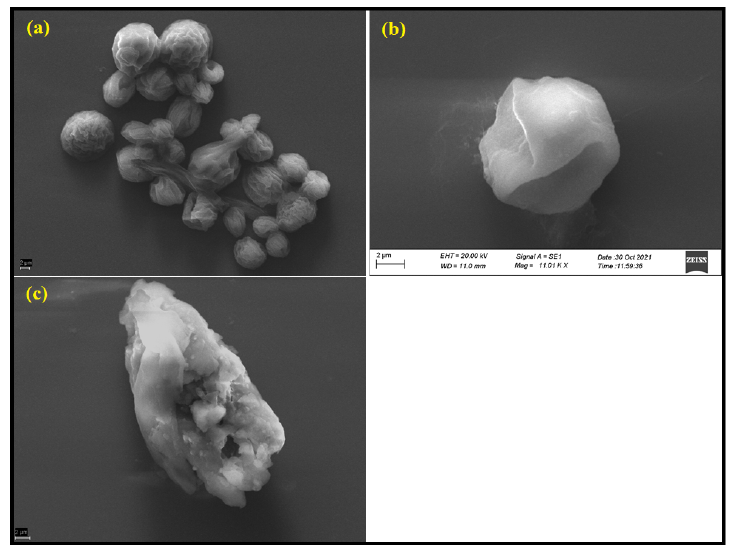
Figure 7. Scanning electron microscopy images of sporangiospores: ( a ) control, ( b ) treated with PEI-f-AgNP-1, and ( c ) treated with PEI-f-AgNP-2 for 24 h. Further, the EDS analysis of PEI-f-Ag-NP 1 and 2 treated sporangiospores was used to assess the presence of elemental silver distribution in the sporangiospores. In PEI-f-AgNP- 1- and water-treated sporangiospores, no elemental silver was detected, as shown in Figure 8a,b. In contrast, elemental silver was detected in PEI-f-AgNP-2-treated sporangiospores (Figure 8c), suggesting different interaction dynamics of each type of PEI-f-Ag-NPs.